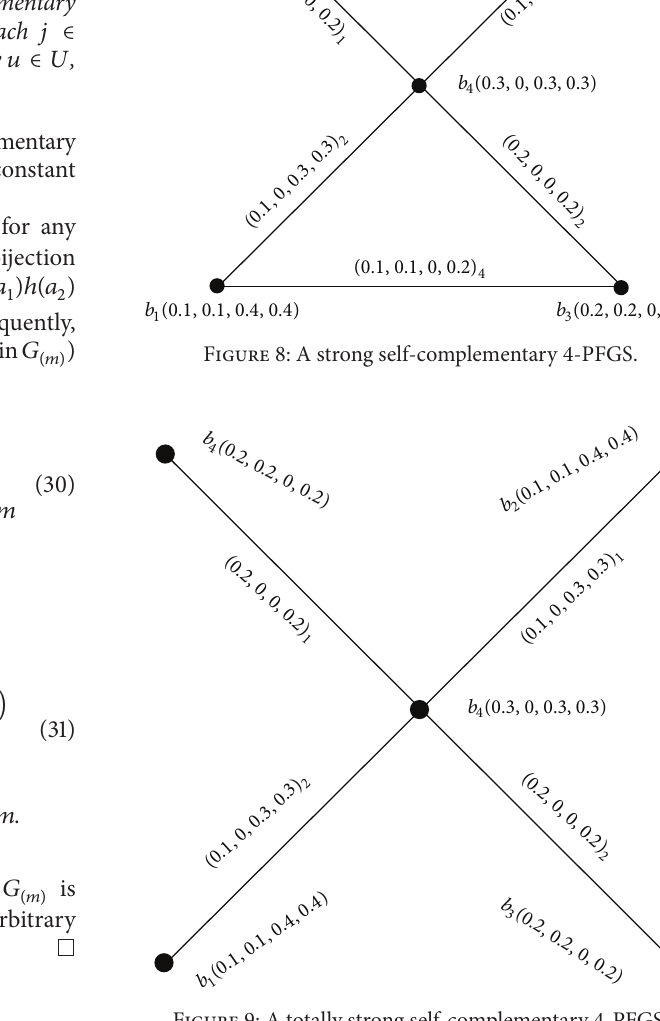
Figure 9: A totally strong self-complementary